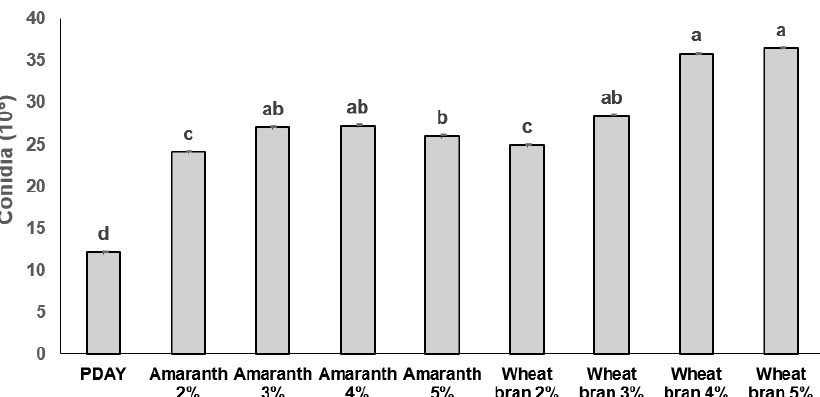
Figure 2. Hirsutella citriformis conidia production on protein supplements. Fungi conidia production was determined after culturing with protein supplements, as explained in the text. The PDAY bar represents potato dextrose agar + 1% yeast extract culture. The other bars represent dextrose, peptone, and yeast extract agar (DPYA), supplemented with amaranth or wheat bran at 2%, 3%, 4%, and 5%. Different letters indicate significant statistical differences, and bars indicate the standard error of the mean (Tukey test).